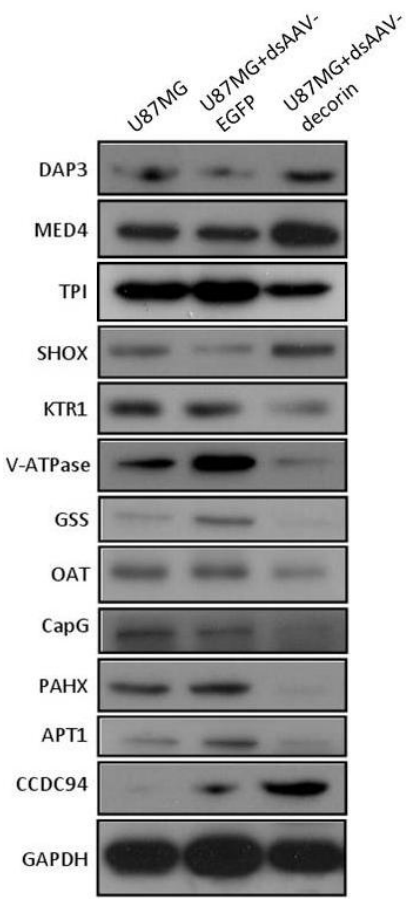
Figure 6. Multi-connections of decorin with critical biochemical mechanisms to GBM biology. Western blot showing the protein expression patterns that are up- or down-regulated in U87MG cells by dsAAV-decorin